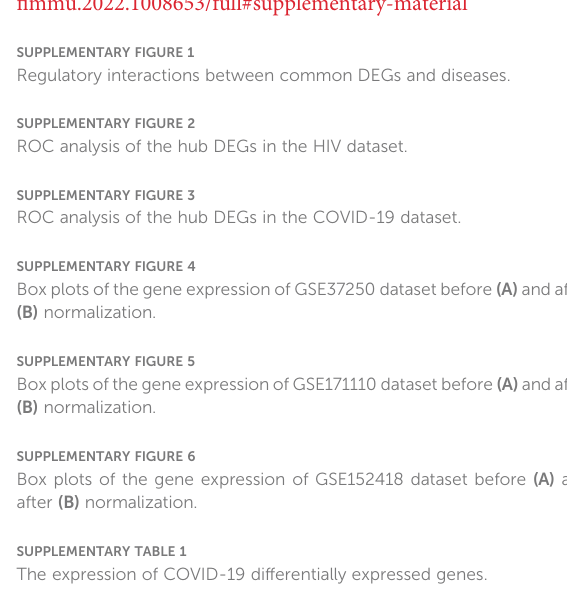
SUPPLEMENTARY FIGURE 1 Regulatory interactions between common DEGs and diseases. SUPPLEMENTARY FIGURE 2 ROC analysis of the hub DEGs in the HIV dataset. SUPPLEMENTARY FIGURE 3 ROC analysis of the hub DEGs in the COVID-19 dataset. SUPPLEMENTARY FIGURE 4 Box plots of the gene expression of GSE37250 dataset before (A) and after (B) normalization. SUPPLEMENTARY FIGURE 5 BoxplotsofthegeneexpressionofGSE171110datasetbefore (A) andafter (B) normalization. SUPPLEMENTARY FIGURE 6 Box plots of the gene expression of GSE152418 dataset before (A) and after (B) normalization. SUPPLEMENTARY TABLE 1 The expression of COVID-19 differentially expressed